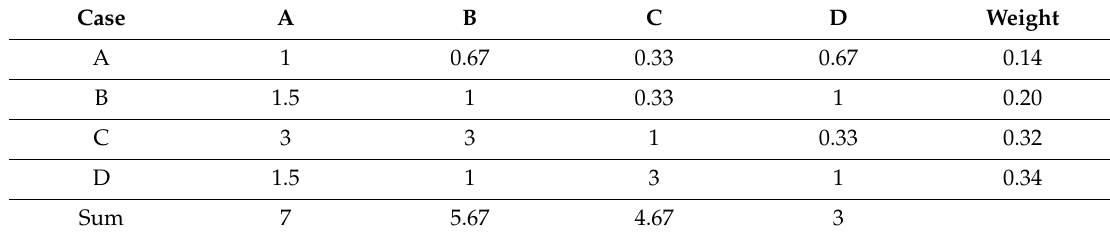
Table A4. Pairwise comparison of alternatives based on Environmental.